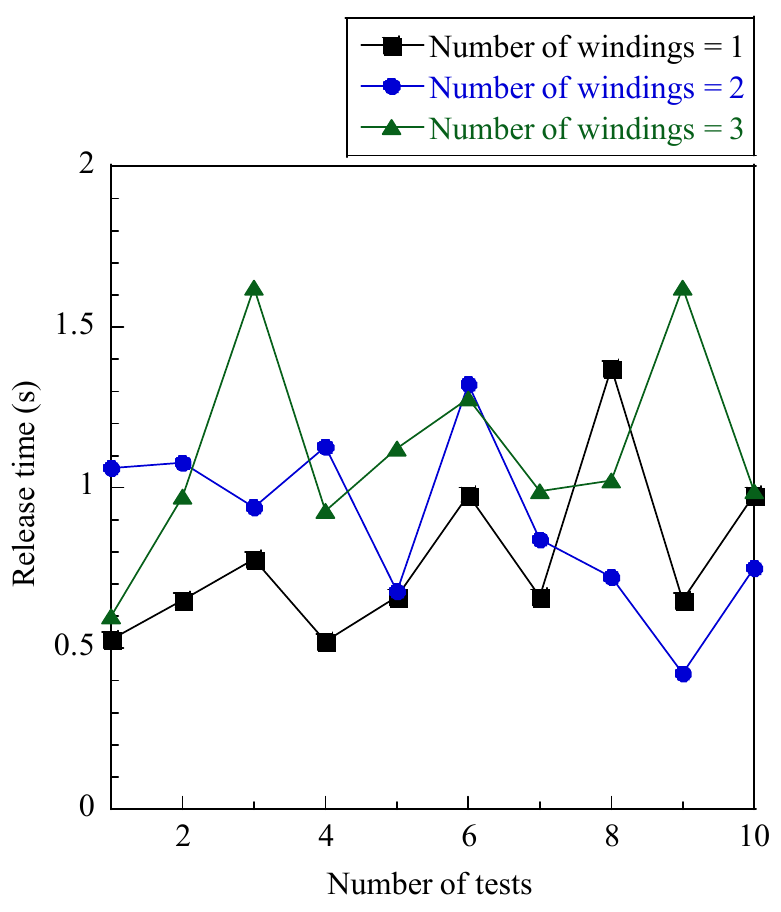
Figure 12. Release times of the proposed mechanism in repetitive release function test.